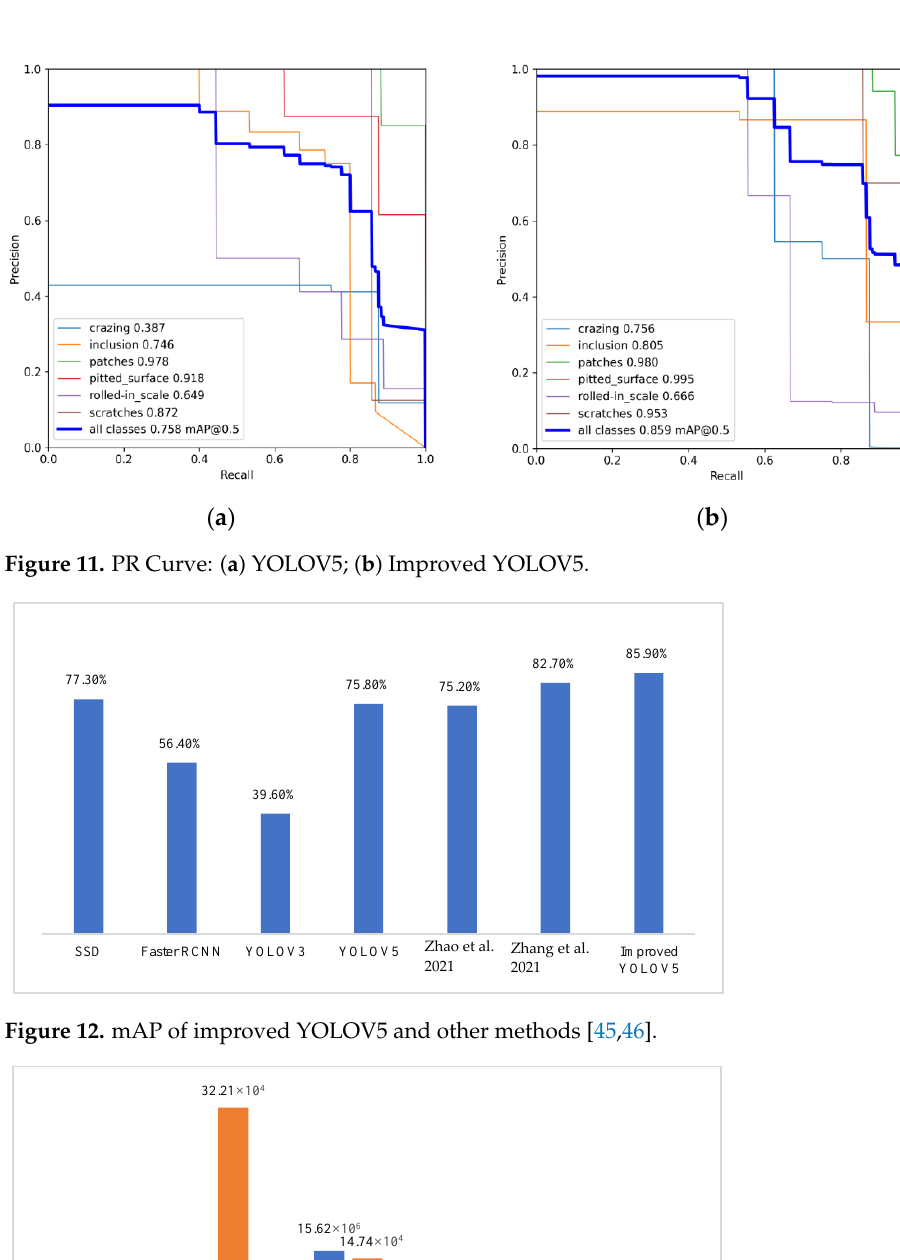
Figure 12. mAP of improved YOLOV5 and other methods [45,46].